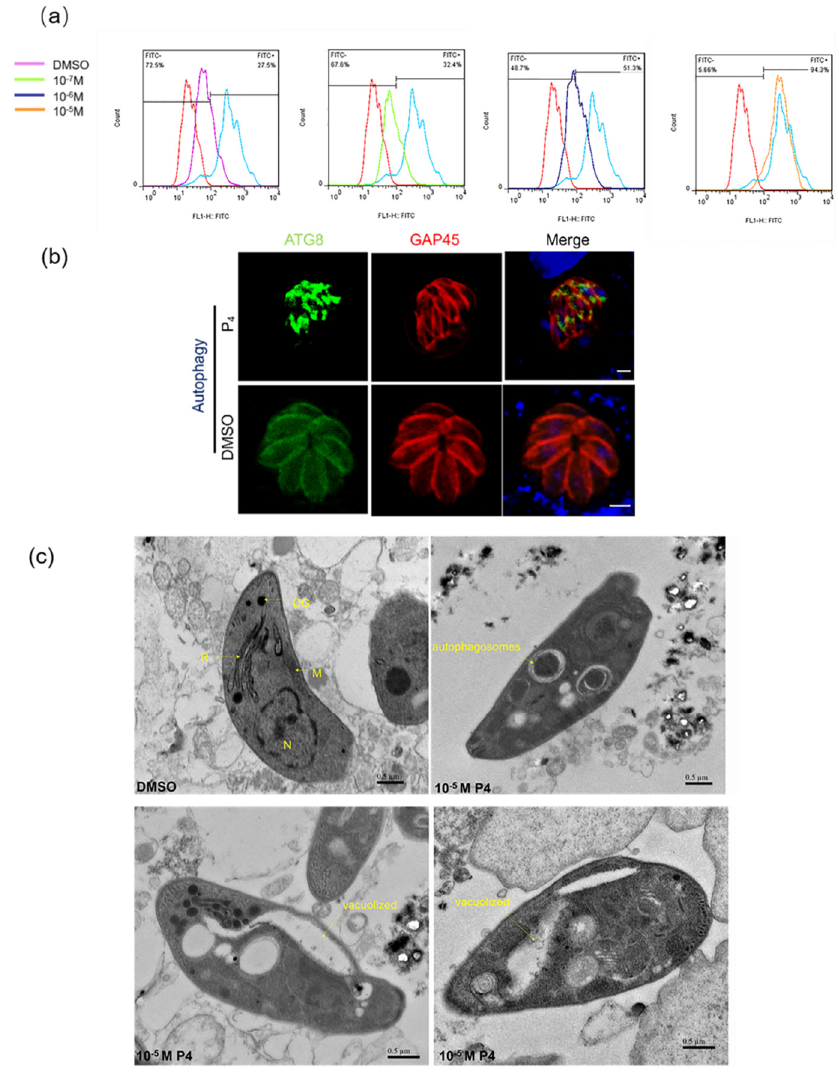
Figure 3. Progesterone induced autophagy in T. gondii : ( a ) Parasites were incubated with 10 − 7 M, 10 − 6 M, and 10 − 5 M progesterone for 3 h; then, parasites were stained with TUNEL and analyzed by flow cytometry; ( b ) Immunofluorescence results showed that 10 − 5 M progesterone promoted the accumulation of ATG8 in the cytoplasm of T. gondii . Scale bar, 2 μ m; ( c ) Ultrastructural changes of T. gondii tachyzoites after being treated with P4. The well-preserved tachyzoite structures were maintained in the control group, including the nucleus (N), rhoptries (R), dense granules (DG), and mitochondrion (M). P4 treatment for 3 h caused many autophagosomes and vacuoles to emerge in the cytoplasm, as indicated by the arrows. Scale bar, 0.5 μ m.